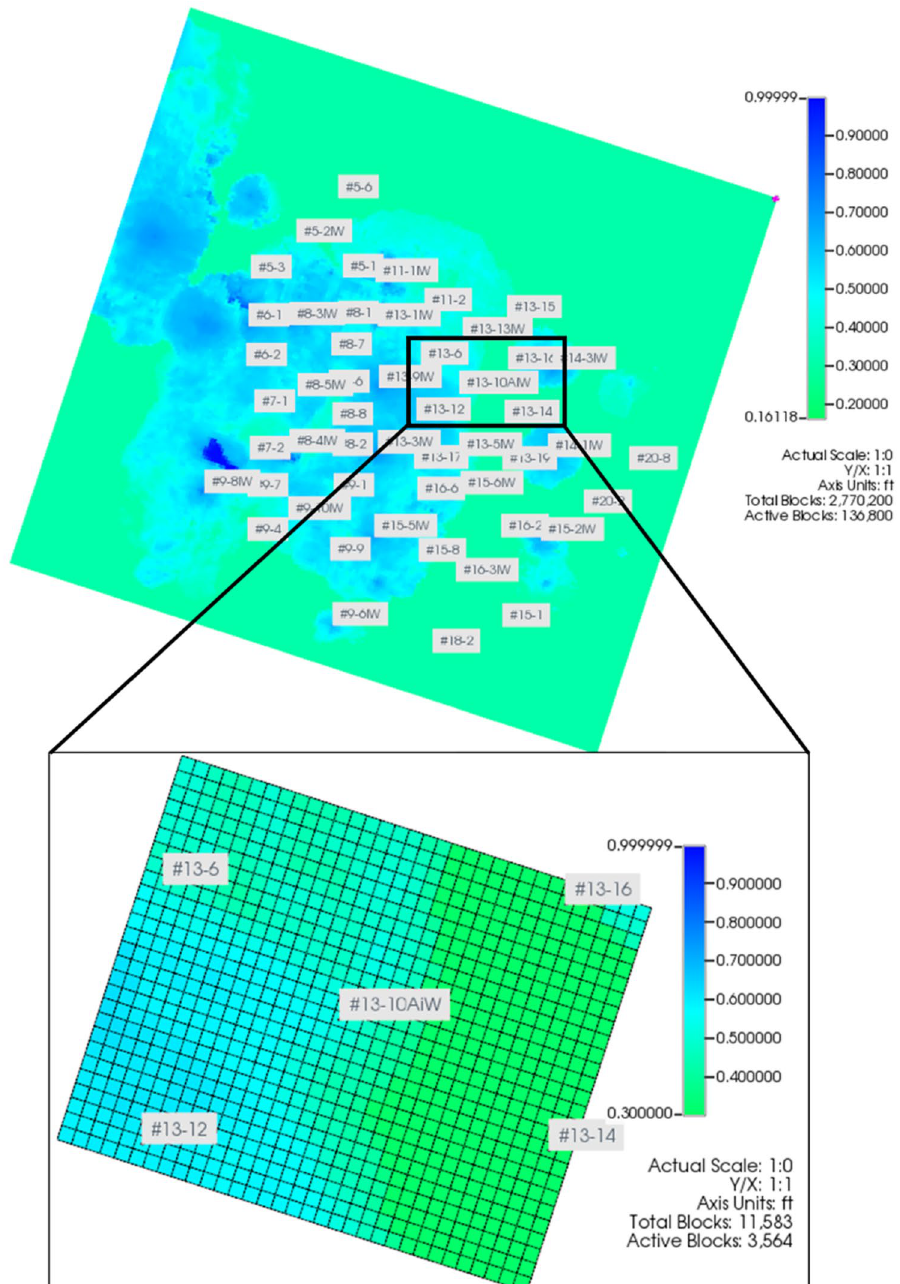
Figure 2. Extracted sector model (13-10A inverted 5-spot pattern) from field-scale reservoir